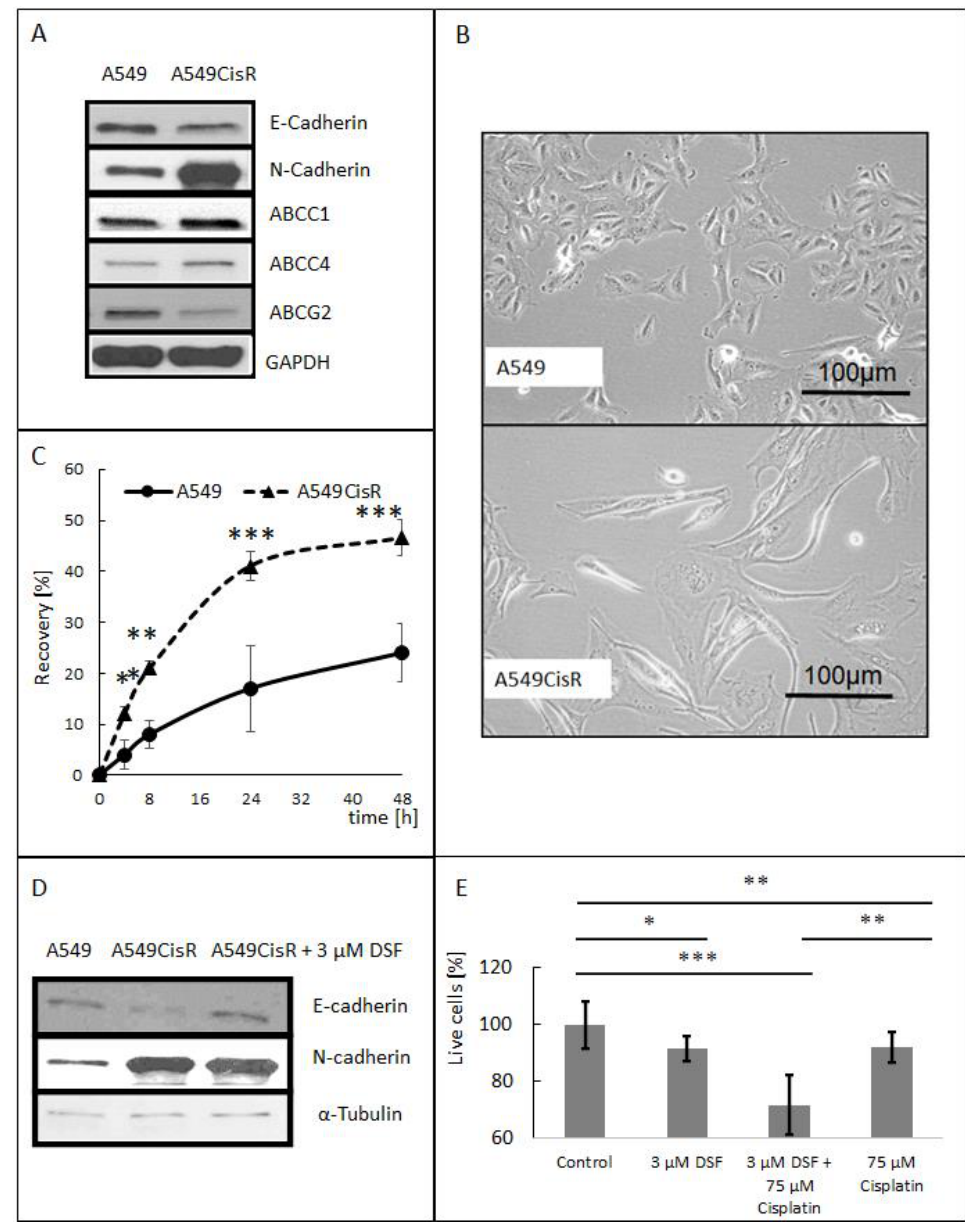
Figure 1. Characteristics of the cisplatin-resistant A549 cell line and DSF reversion of cisplatin resistance. ( A ) Western blot analysis of EMT markers and ABC proteins, performed in standard reducing SDS PAGE conditions. ( B ) Cell morphology (phase contrast microscopy). ( C ) Wound healing such as analysis of resistant-cell migration. A549 and A549CisR cells were seeded on a six-well plate and grown to confluence. Next, a wound was created and rinsed twice with PBS. New full medium was added. Wounded area was visualized after 0, 4, 8, 24, and 48 h using an OLYMPUS IX53 microscope and calculated by ImageJ software, n = 4, * p < 0.05; ** p < 0.005; *** p < 0.001, NS—not statistically significant. ( D ) DSF treatment reverses cisplatin resistance. Standard SDS-PAGE Western blot analysis of EMT markers. The A549CisR cells were treated with 3 µ M DSF (48 h), and cell lysates were obtained using M-PER Mammalian Protein Extraction Reagent #78501 as described in Materials and Methods. ( E ) To determine the impact of DSF on cell viability, A549CisR cells were seeded on 96-well plates and treated with 75 µ M cisplatin, 3 µ M DSF, and 3 µ M DSF 75 µ M cisplatin. After 48 h, cell viability was tested using WST-1 assay (ScienCell, Research Lab., Carlsbad, CA, USA); n = 3, * p < 0.05; ** p < 0.005; *** p < 0.001, NS—not statistically Regarding the effect of cisplatin resistance related changes on NSCLC migration, A549CisR presented a higher 2D migration rate (observed in wound healing assay) than